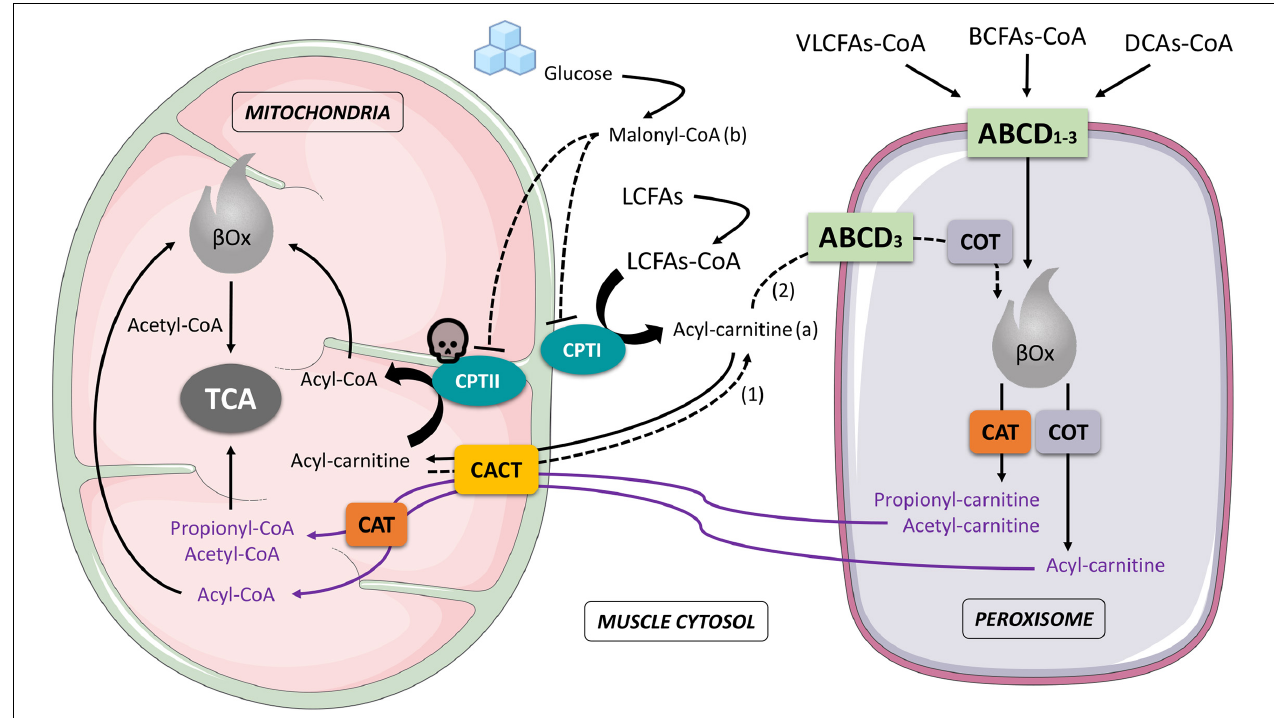
FIGURE 1 | Schematic interaction that involves mitochondria and peroxisome during muscle cell fatty acids oxidation. The figure highlights the importance of this interaction in the case of a CPTII deficiency: Acyl-carnitine accumulated in the cytosol (a), produced by LCFAs-CoA through the activity of CPTI, and coming from the mitochondria (dashed arrow 1), is partially recycled by the peroxisome (dashed arrow 2), subjected to peroxisomal β Ox to produce other Acyl-carnitine compounds (e.g., Hexanoyl-carnitine) then reconveyed to mitochondria and reconverted into CoA forms (Acyl-CoA) before being processed in the mitochondrial β Ox. In the presence of a high concentration of Malonyl-CoA (b), due to a greater availability of glucose, CPTI and CPTII are both inhibited and LCFAs are mostly deviated to muscle storage (pathways not shown in the figure) instead of being oxidized. ABCD1-3, ATP Binding Cassette subfamily D transporters 1-3; CAT, carnitine acetyltransferase; CACT, carnitine-acylcarnitine translocase; COT, carnitine octanoyltransferase; CPTI, carnitine palmitoyl-transferase I; CPTII, carnitine palmitoyl-transferase II; β Ox, beta oxidation; BCFAs-CoA, branched-chain fatty acid-CoA; DCAs-CoA, dicarboxylic acids-CoA; LCFAs-CoA, long-chain fatty acids-CoA; VLCFAs-CoA, very-long-chain fatty acids; TCA, tricarboxylic acid cycle; skull, indicates the CPTII deficiency; arrows and dashed arrows, indicate processes or molecular movements; dashed T-bars, indicate